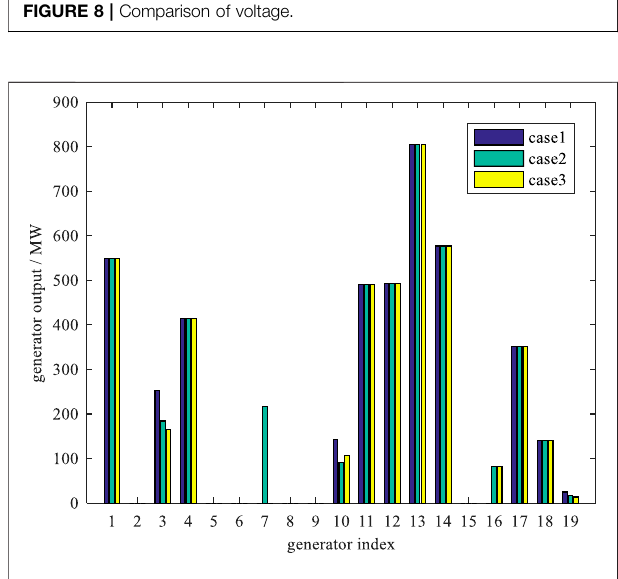
FIGURE 9 | Comparison of generator